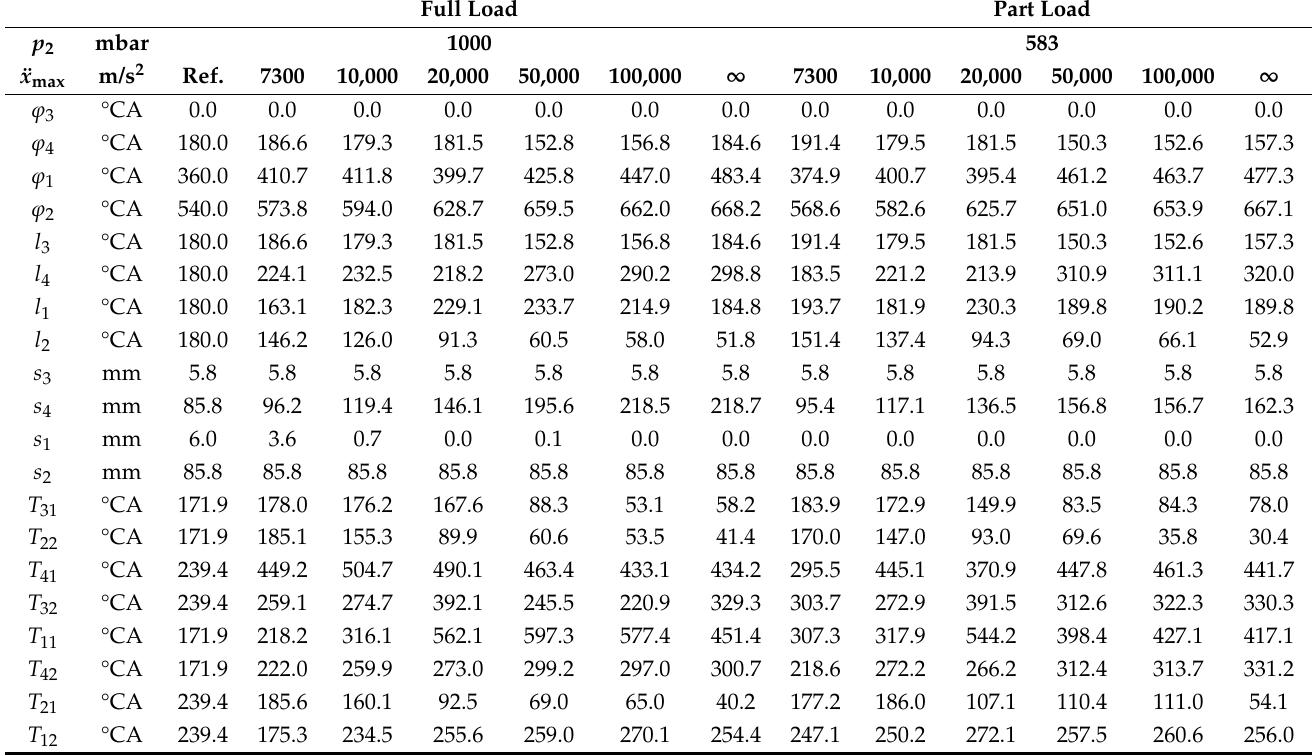
Table A1. Parameter for optimized trajectories according to Figure